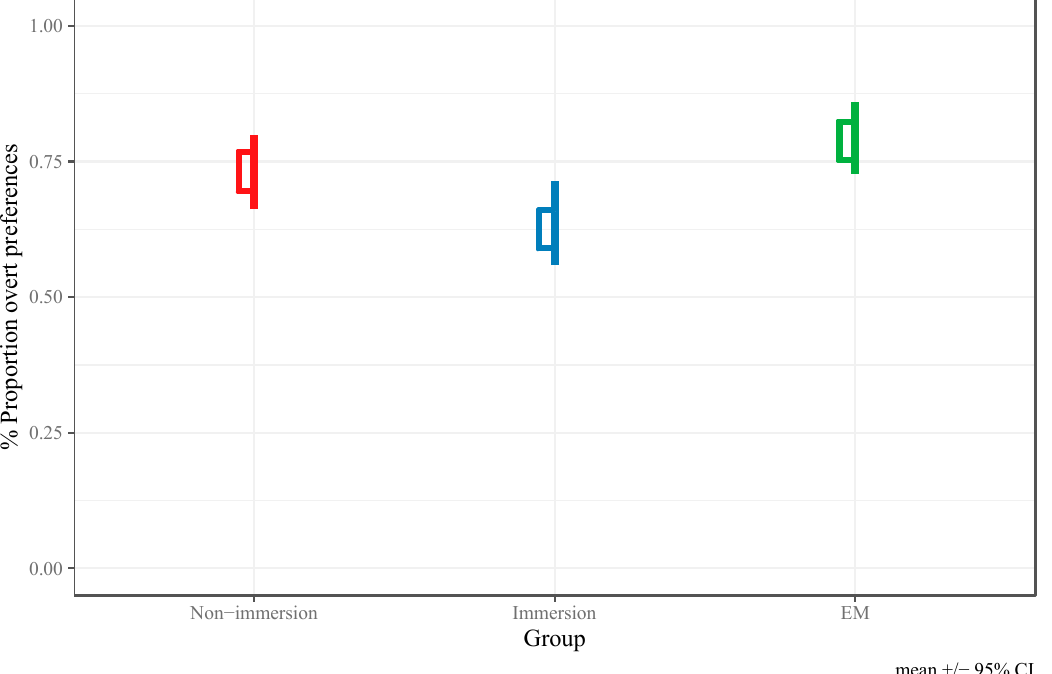
Figure 2. Proportion of overt responses in English as a function of age (centered) and group. Table 3. Coefficients in English. Group